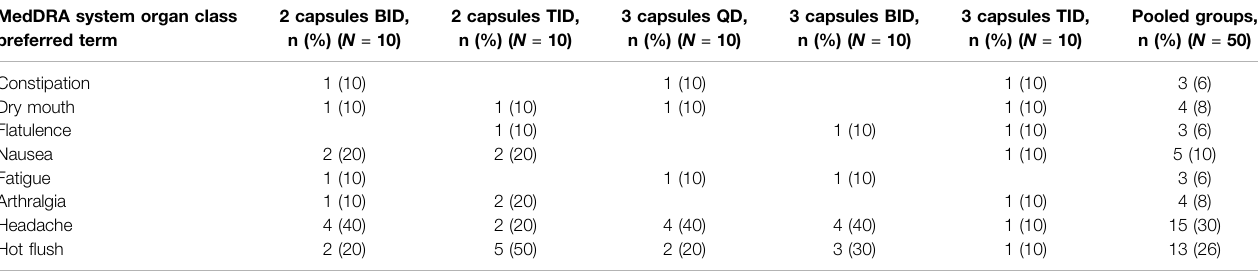
TABLE 3 | Adverse events reported. Number and proportion of subjects with adverse events reported with a frequency of more than 5% in the total safety population is